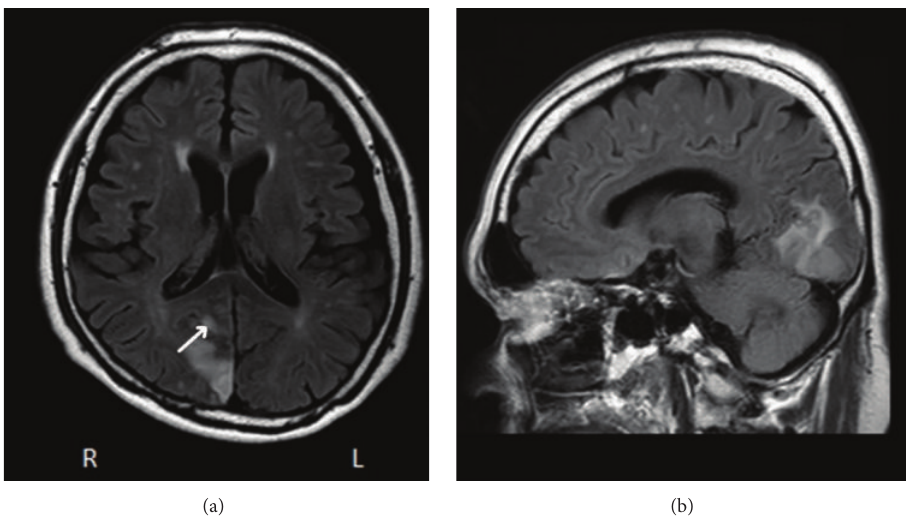
Figure 1: FLAIR MRI scan of the case on (a) axial and (b) sagittal views. High-signal intensity can be seen in the right posteromedial region that extended into the anterior bank of the parietooccipital sulcus (arrow). FLAIR: fluid attenuated inversion recovery; MRI: magnetic resonance